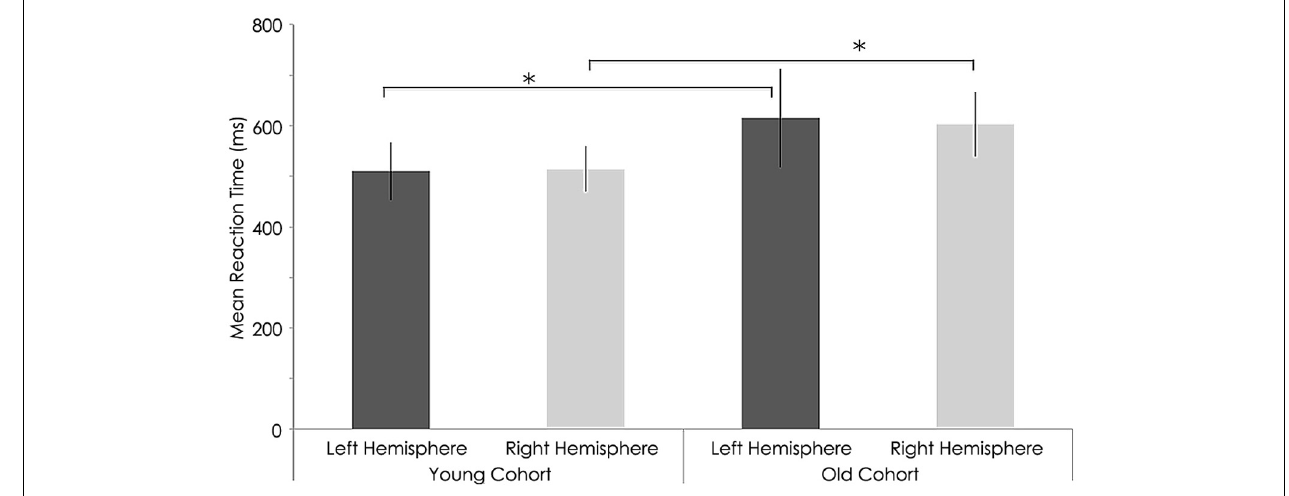
hemispheres ( p = 0 . 012) and left hemisphere ( p = 0 . 01, Wilcoxon signed-rank test) among young and older subjects. ∗ , statistically significant ( p < 0 . 05).